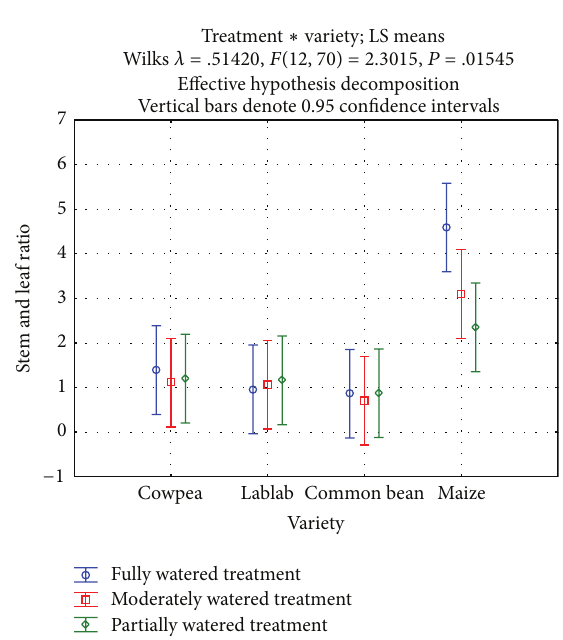
Figure 6: Stem-leaf ratio in different legumes according to different watering